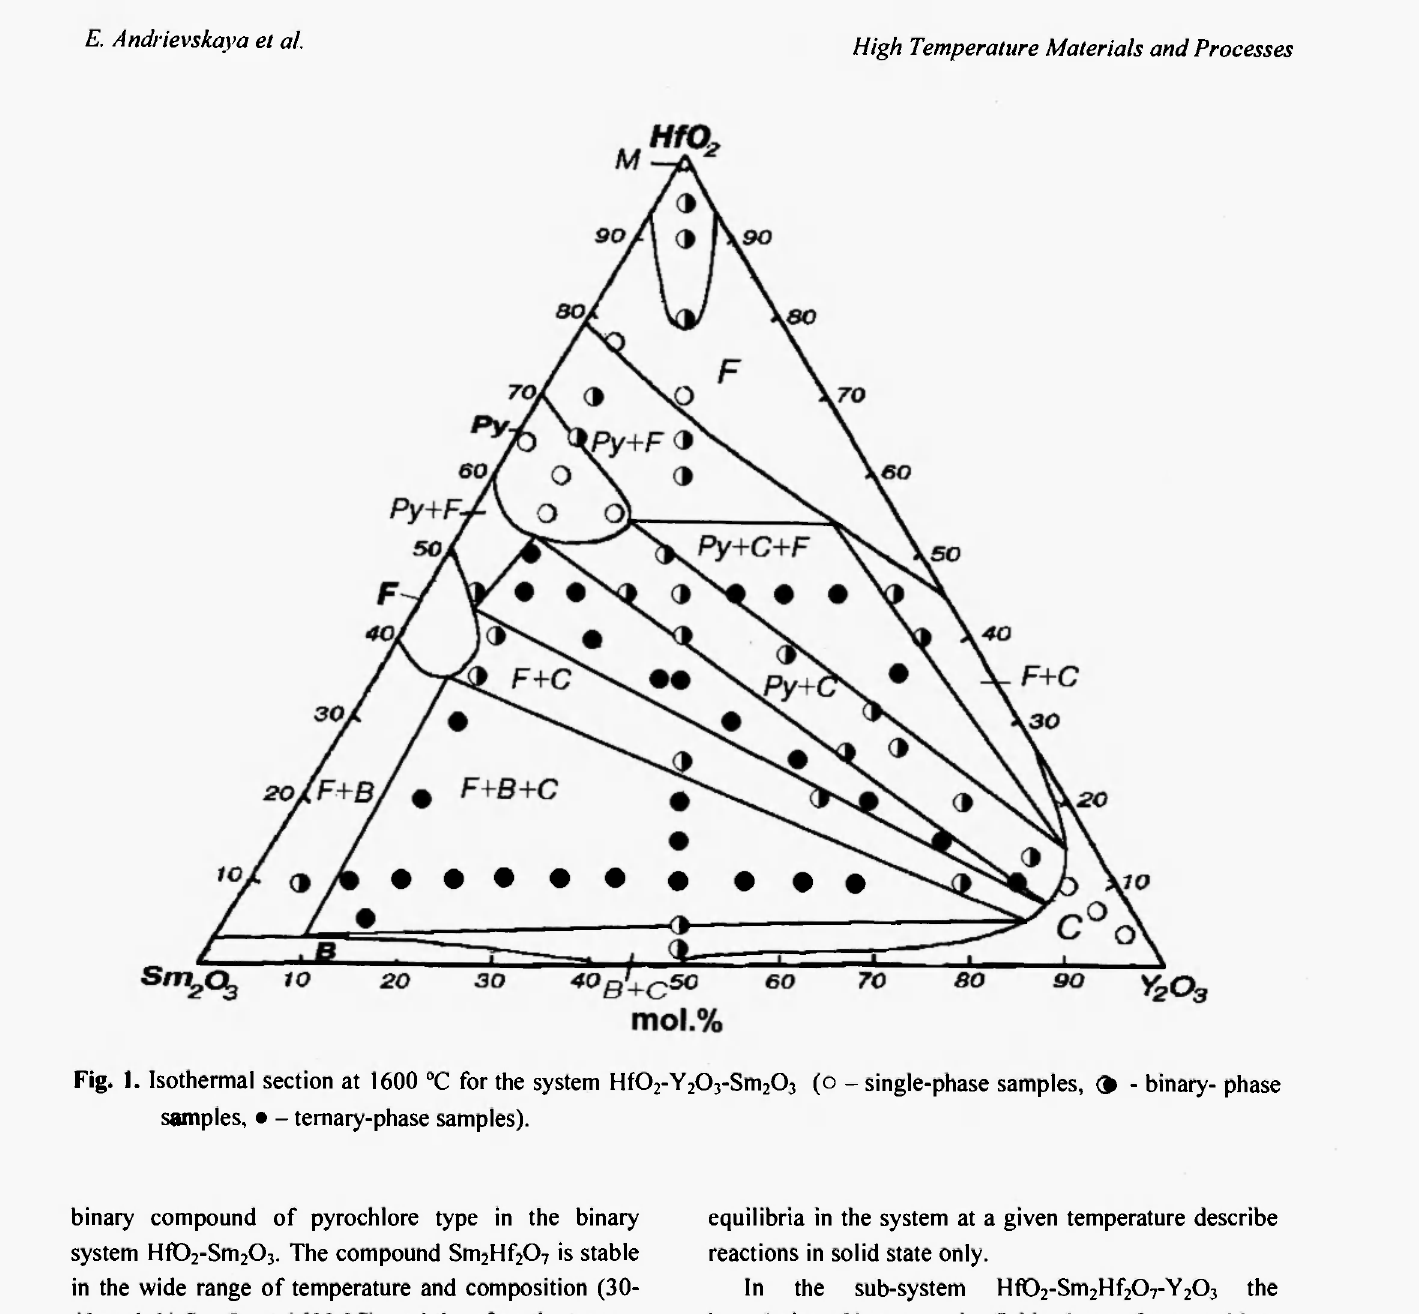
Fig. 1. Isothermal section at 1600 °C for the system Hf0 2 -Y203-Sm 2 03 (ο - single-phase samples, φ - binary- phase samples, · - ternary-phase